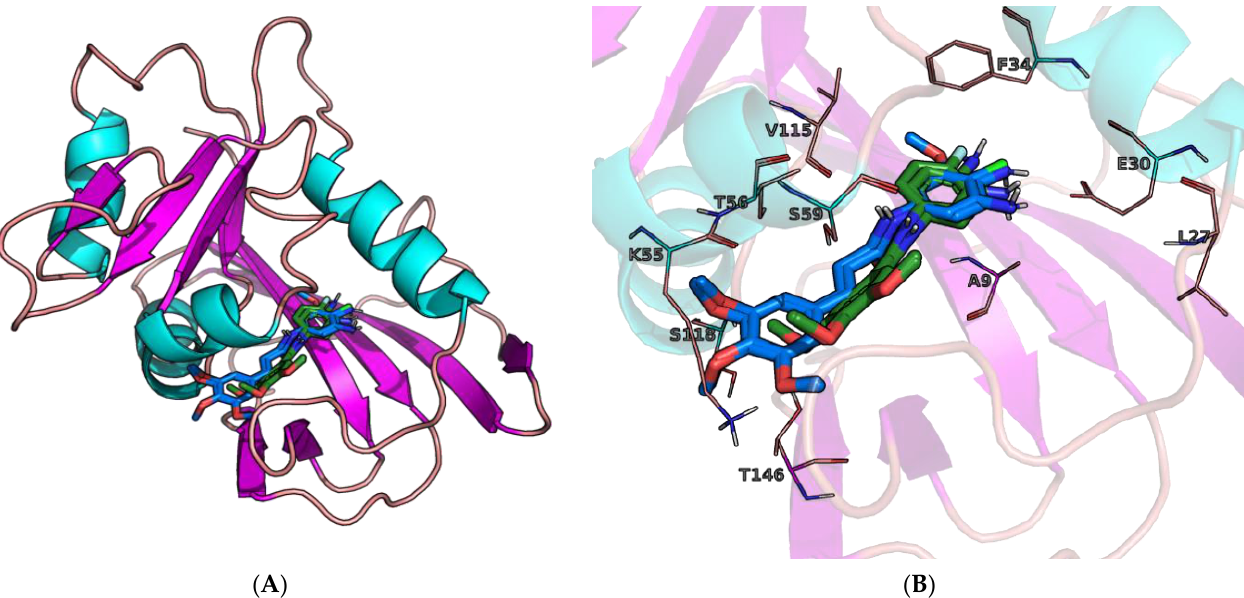
Figure 5. ( A ) Binding modes of derivatives 2 , 6 (green) and 13 , 14 , 16 (blue) at active site of human dihydrofolate reductase ( h DHFR). Analogs with the same molecular scaffold overlap. ( B ) Figure on the right is a close-up of the active site with the main residues involved in interactions highlighted.